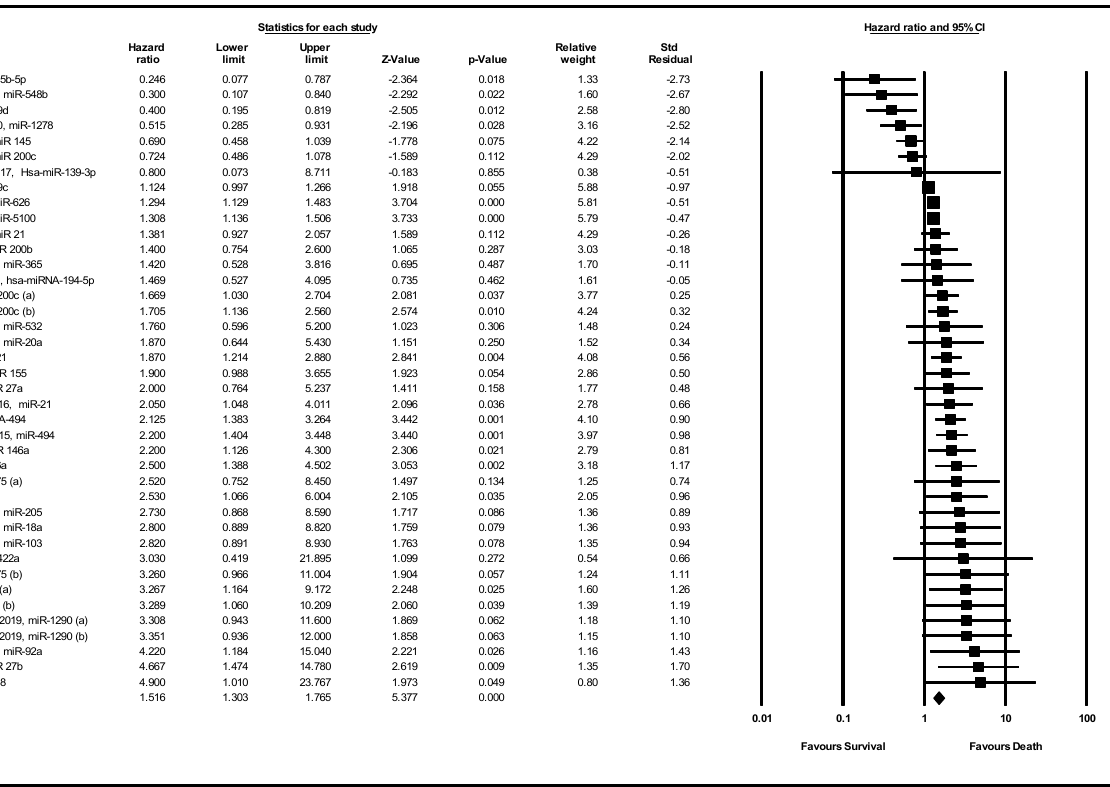
23 of 28 Figure 5. Funnel plot of the studies included in this comprehensive meta-analysis of miRNA.. Funnel plot with inputted studies (studies included in this comprehensive meta-analysis of miRNA- specific chemoresistance in head and neck cancer). The black circles indicate imputed studies. 3.7. Orwin’s Fail-Safe N Test In the studies in this meta-analysis review, the hazard ratio (HR) values were measured to be 1.30155. The mean hazard ratio cited in the results was 1.000 (generally can consist of any value other than a nil value). In this review, the HR observed to be